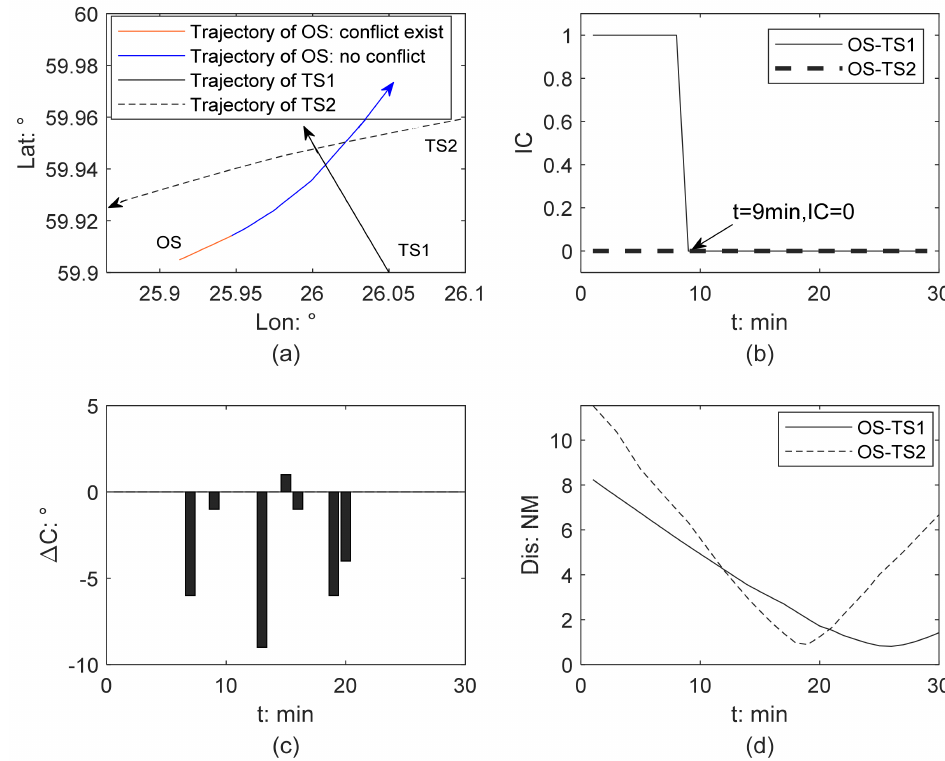
Figure 9. Ship collision detection from GW perspective in Scenario 3 ( a ) ship trajectory; ( b ) ship collision risk identification; ( c ) course change of a GW; ( d ) relative distance between each two ships.